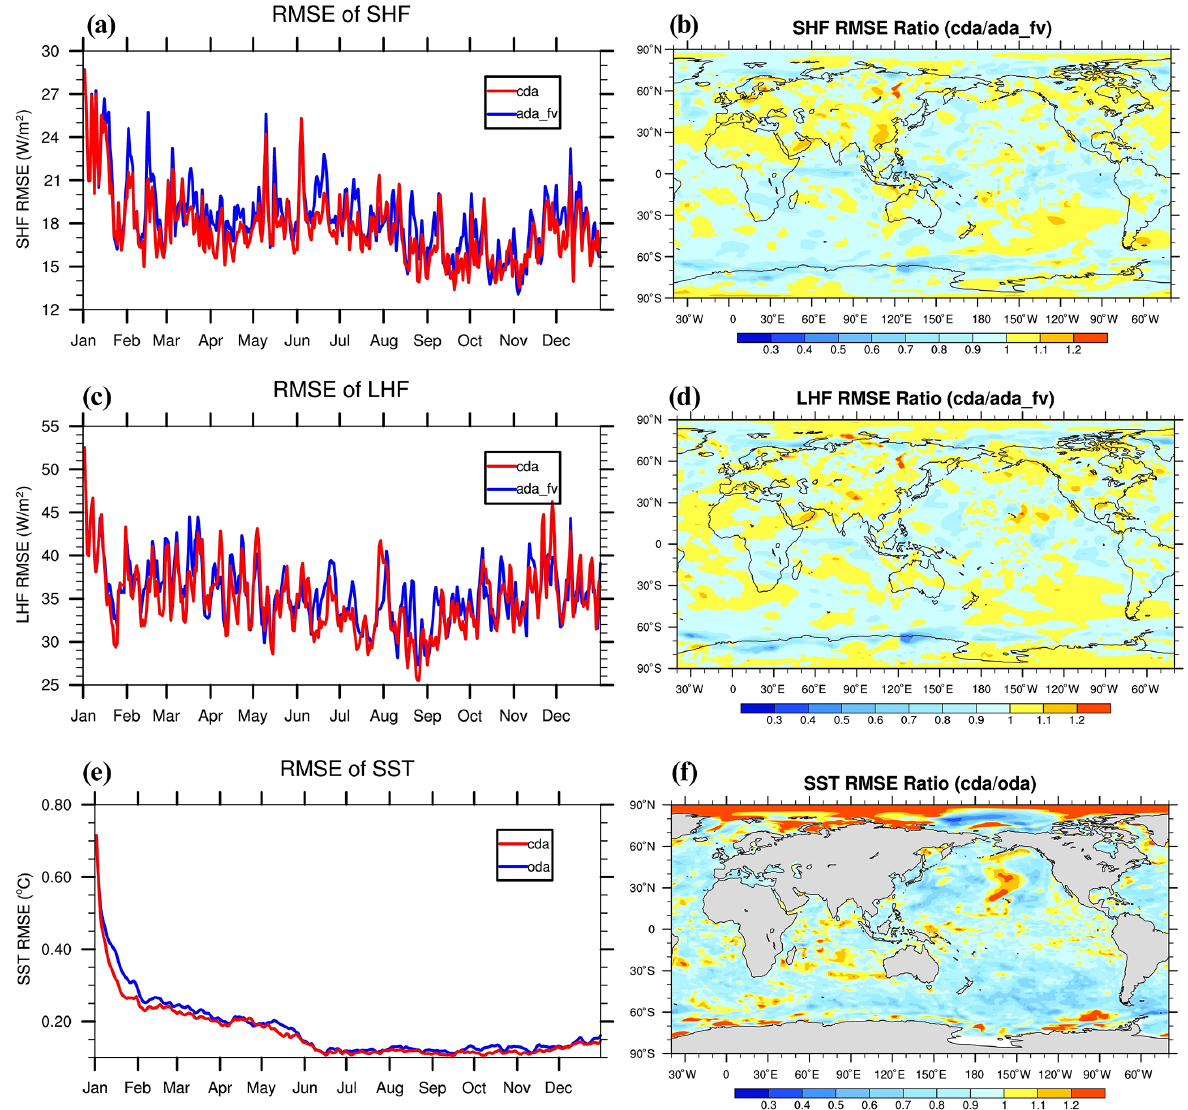
Figure 14. Time series of RMSEs of (a) sensible heat flux (SHF), (c) latent heat flux (LHF) from ada_fv and cda, and (e) SST from oda_sst and cda and distribution of the RMSE ratio of (b) SHF (cda / ada_fv), (d) LHF (cda / ada_fv), and (f) SST(cda/oda). The RMSE ratios are calculated with the data of the first month